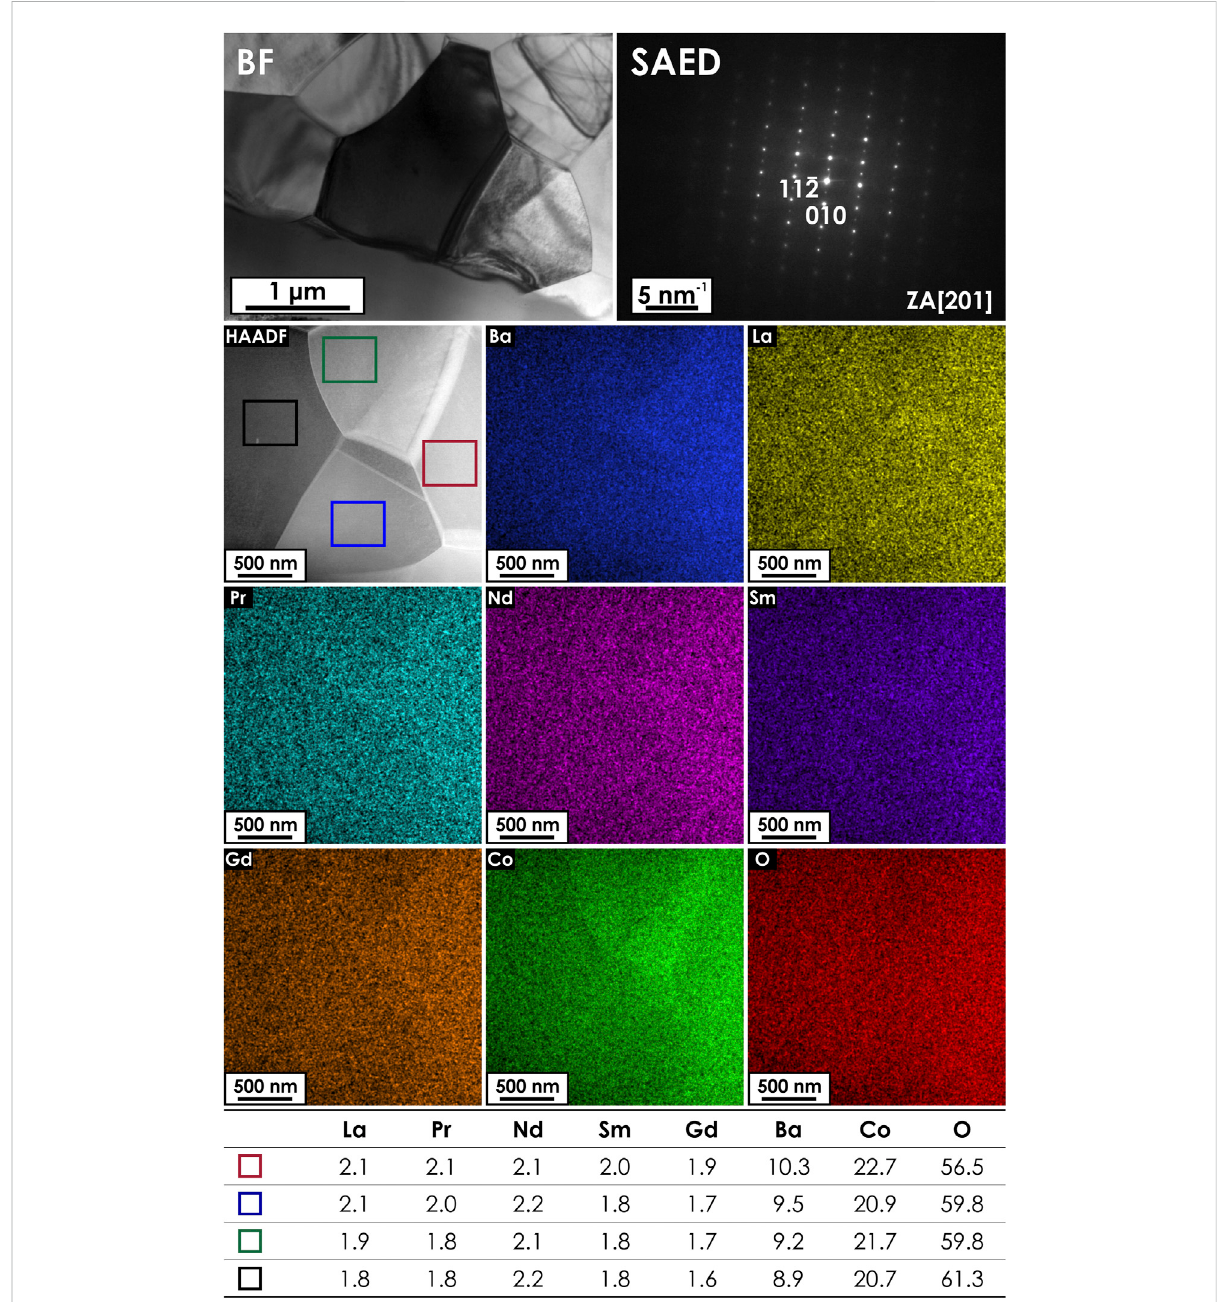
FIGURE 3 Exemplary bright fi eld image(upperleft-handcorner) andthecorresponding SAED pattern(upper right-hand corner), takenfrom athinlamella of the (La,Pr,Nd,Sm,Gd)BaCo2O5+ δ sample. The zone axis (ZA) along which the SAED pattern was taken is indicated. The lower part of the fi gure presents the results of STEM/EDS mapping, with the corresponding elemental distribution maps across the studied area. The results of the EDS analysis in typical micro areas in four different grains are also provided